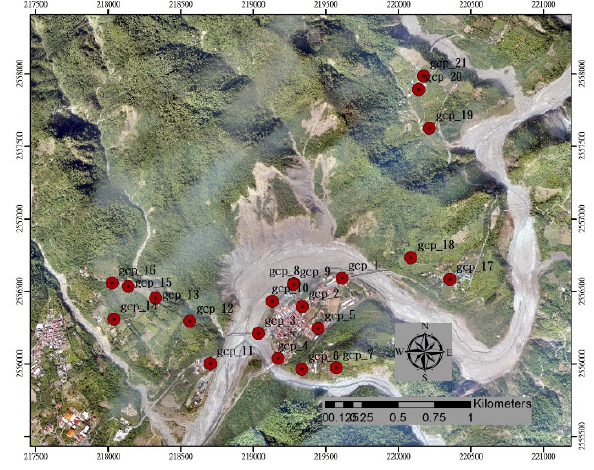
Figure 2. Distribution of ground control points